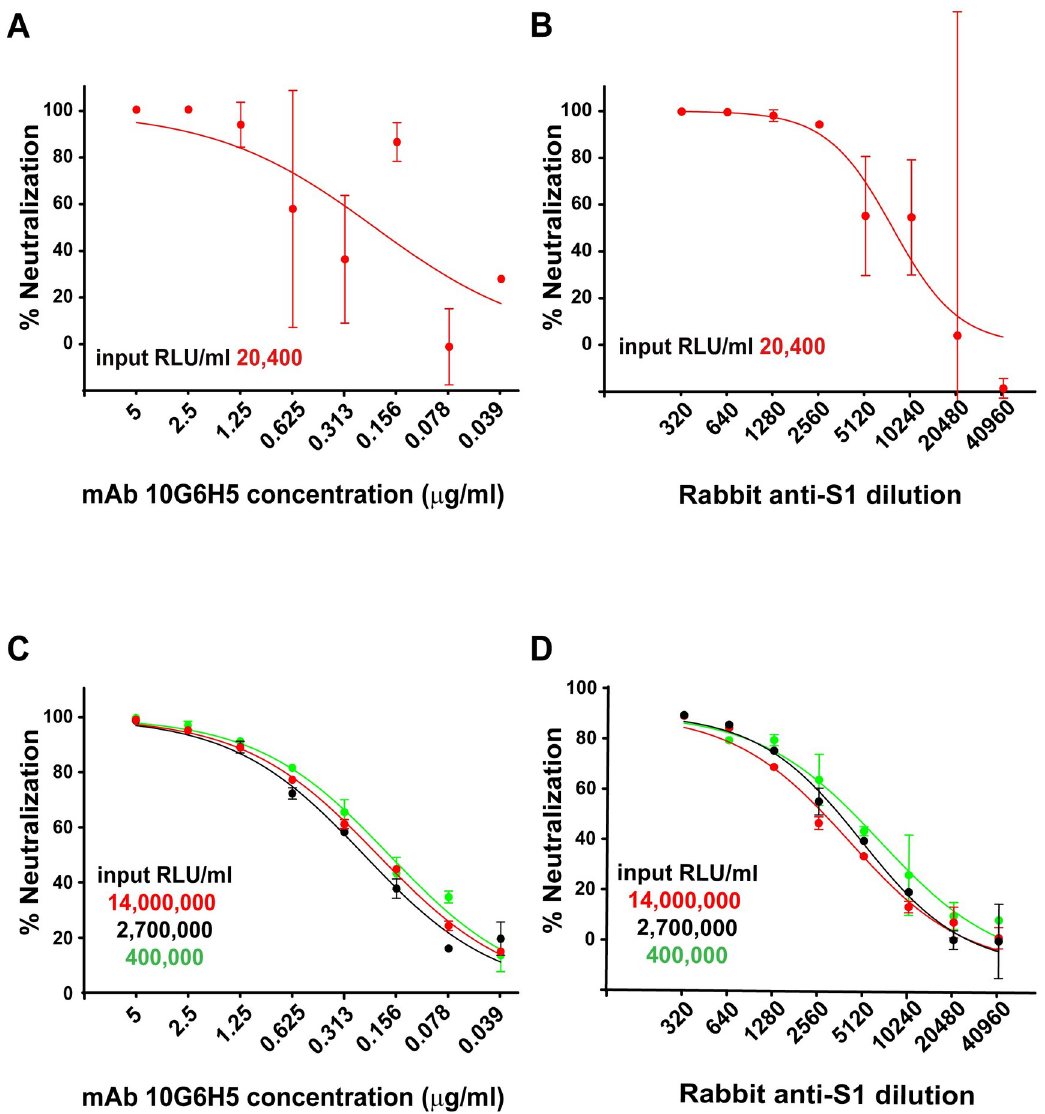
Fig 4. Optimization of pseudovirus inoculum for neutralization assays. Neutralizations were performed in 293T-ACE2. TMPRSS2 s cells with mAb 10G6H5 (A and C) and a rabbit serum against the S1 subunit (B and D) using various pseudovirus inoculums. X-axis indicates mAb concentration (A and C) and serum dilution (B and D) used. Y axis indicates percentage inhibition compared to pseudovirus infection without mAb or serum